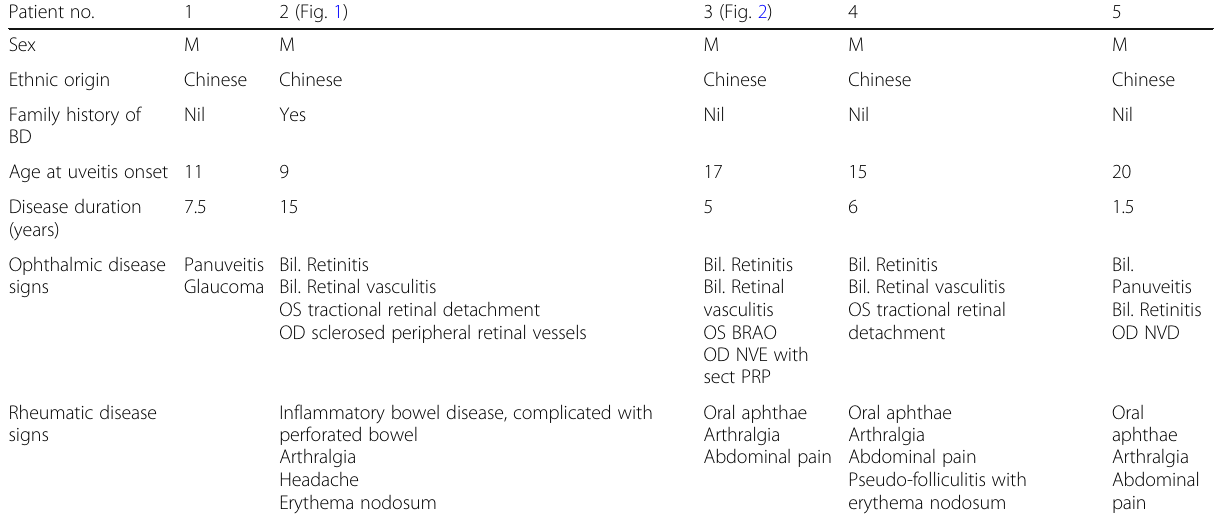
Bil. bilateral, BRAO branch retinal artery occlusion, BD Behcet ’ s disease, M male, NVD neovascularization of the disc, NVE neovascularization